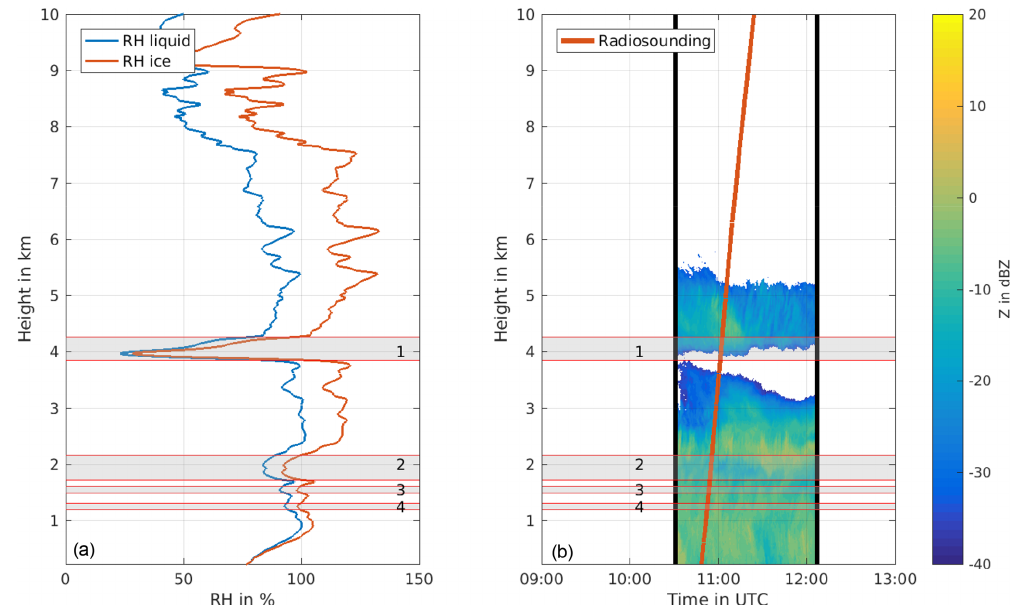
Figure 3. Figures for 3 November 2016 in Ny-Ålesund. (a) Radiosonde profile between 10:48 and 11:24UTC (0 and 10km height). Relative humidity (RH) with respect to water in blue and relative humidity with respect to ice in red. (b) Radar reflectivity factor Z . The red vertical line visualizes the ascent of the radiosonde. The black vertical lines delimit the time period considered for analysing the radar data. The grey colour between the red horizontal lines and the numbers 1, 2, 3 and 4 indicate the subsaturated layers. The grey colour visualizes the subsaturated layers. At the time when the radiosonde reached the supersaturated layer 1 at 3.85km the radiosonde was 3.70km away from the radar due to horizontal wind drift.